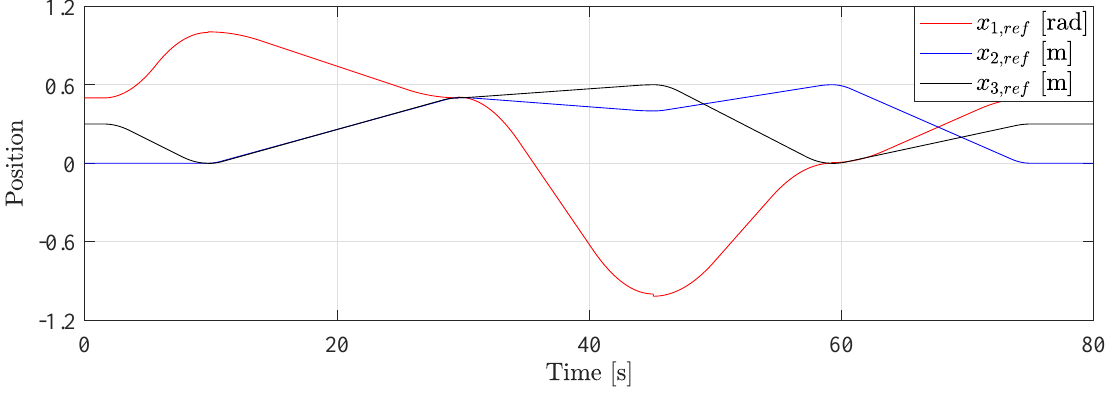
Figure 13. Position reference from simulation.